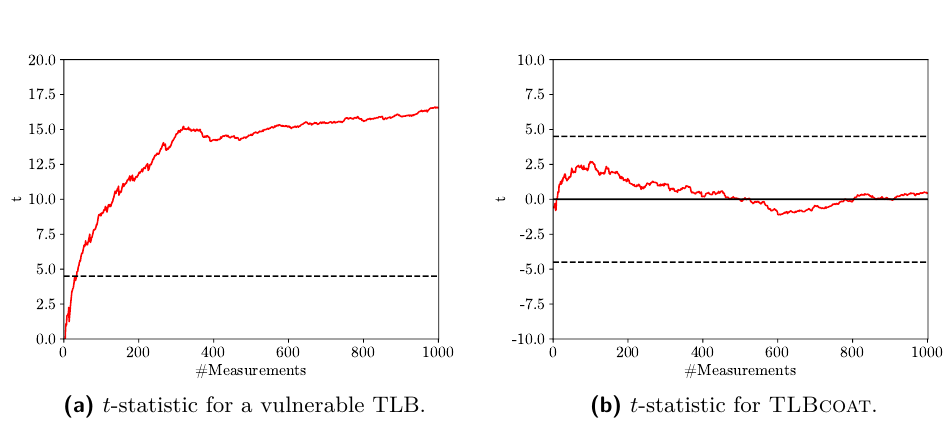
Figure 5: Leakage assessment for set-associative TLBs and TLBcoat using a set of congruent addresses, i.e., aligned on the lower 12